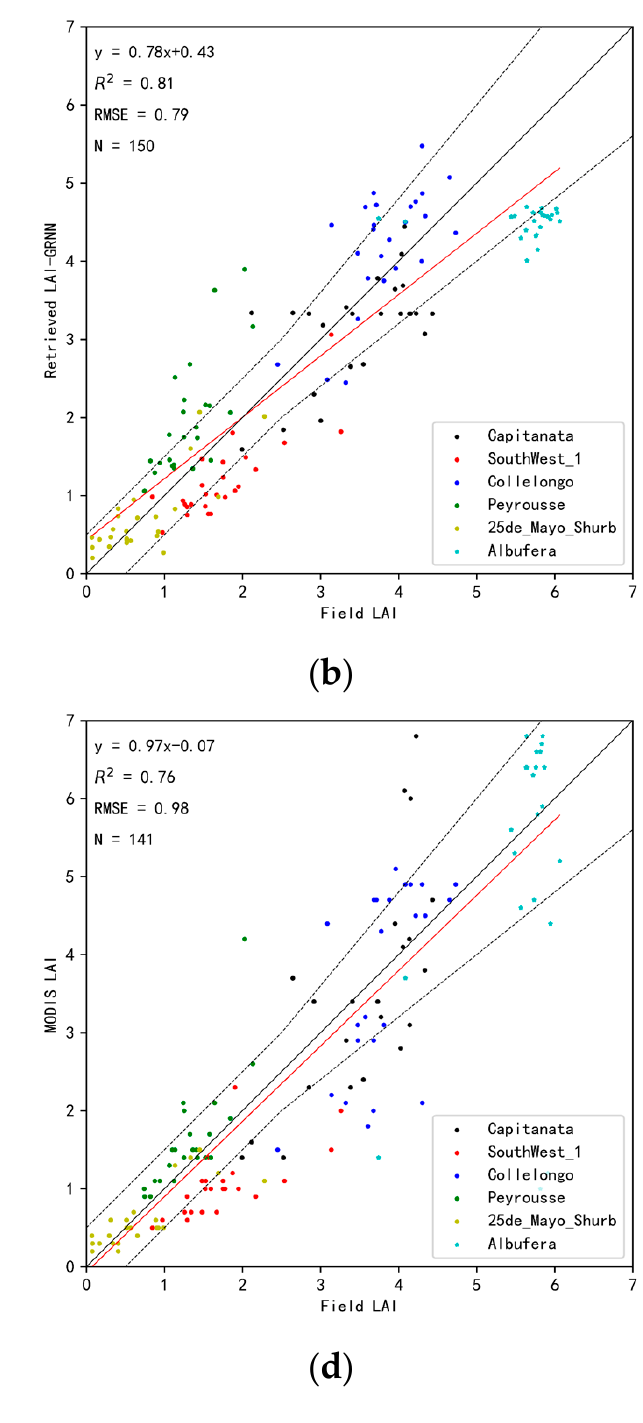
Figure 15. Scatter plots of the LAI-TCA ( a ), the LAI-GRNN ( b ), the VIIRS LAI values ( c ) and the MODIS LAI values ( d ) versus the LAI values acquired from high-resolution reference maps for the six selected sites. The black dashed lines show the uncertainty boundaries proposed by GCOS (max (0.5, 20%)) for LAI.